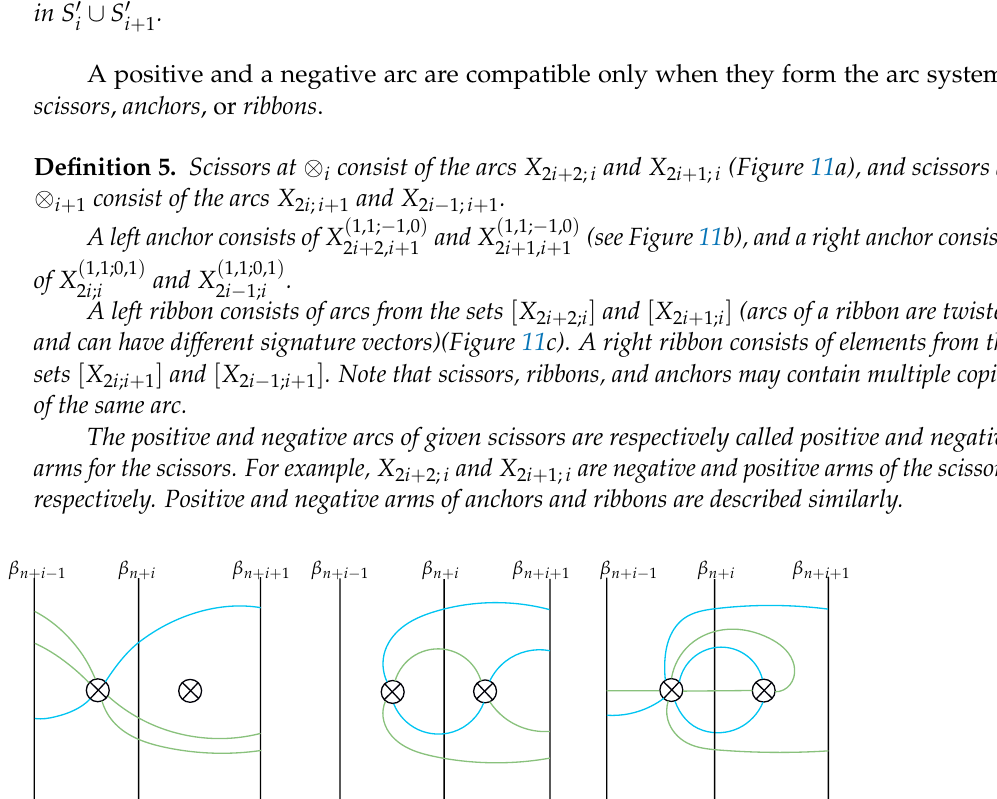
with X 2 i + 2; i = 2 and X 2 i + 1; i = 1, ( b ) a left anchor with X ( 1,1; − 1,0 ) ⊗ i